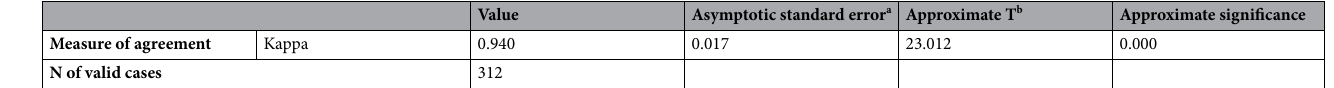
Table 4. The symmetric measures of preoperative ultrasound and diagnostic laparoscopy. a Not assuming the null hypothesis. b Using the asymptotic standard error assuming the null